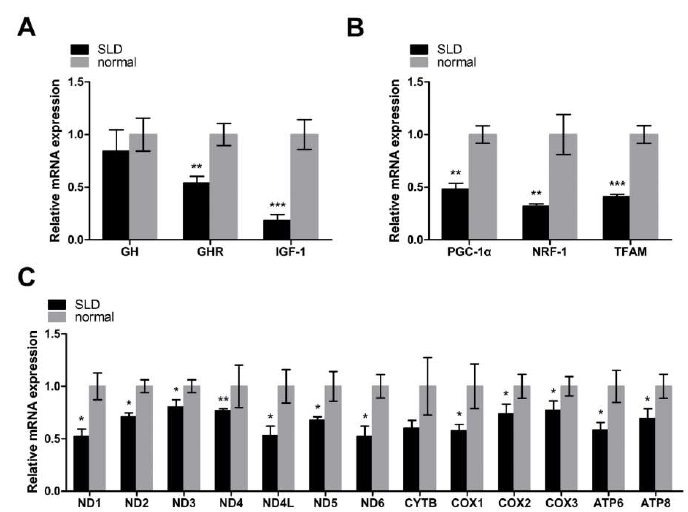
Figure 1. Low expression of key regulators of mitochondrial biogenesis and mtDNA-encoded oxidative phosphorylation (OXPHOS) genes in sex-linked dwarf (SLD) chicken skeletal muscle. ( A ) The relative mRNA expression of genes involved in the GH–GHR–IGF1 signaling pathway was measured by qRT-PCR in SLD chicken skeletal muscle as compared with normal chicken skeletal muscle. ( B ) The relative mRNA expression involved in the PGC1α–NRF1–TFAM signaling pathway was measured by qRT-PCR in SLD chicken skeletal muscle as compared with normal chicken skeletal muscle. ( C ) The relative mRNA expression of mtDNA-encoded OXPHOS genes was measured by qRT-PCR in SLD chicken skeletal muscle as compared with normal chicken skeletal muscle. Data are expressed as means ± SEM, * p < 0.05; ** p < 0.01; *** p < 0.001.